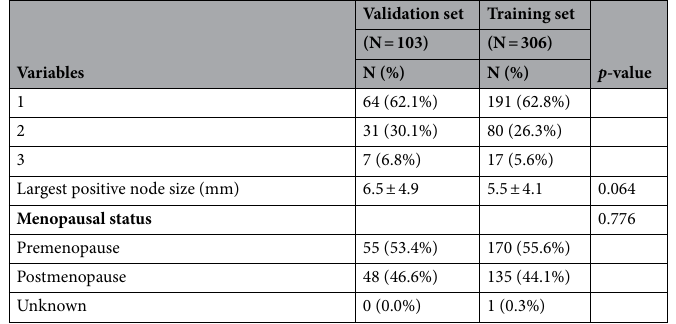
Table 2. Characteristics of validation and training groups. SD, standard deviation.